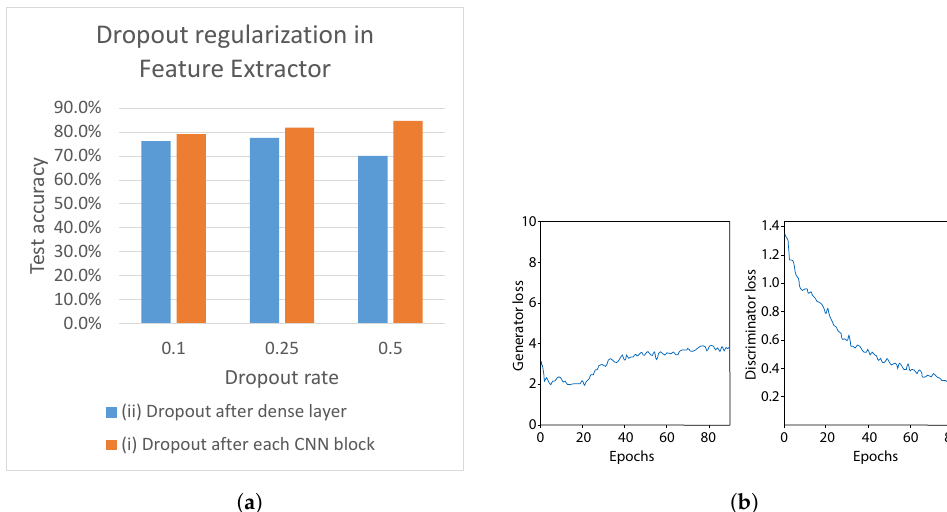
Figure 20. Effect of discriminator regularization. ( a ) Results of applying dropout regularization to the CNN feature extractor and classifier module. ( b ) Comparison between generator and discriminator losses during training, using dropout in UNet and CNN feature extractor, with L 1 loss β =